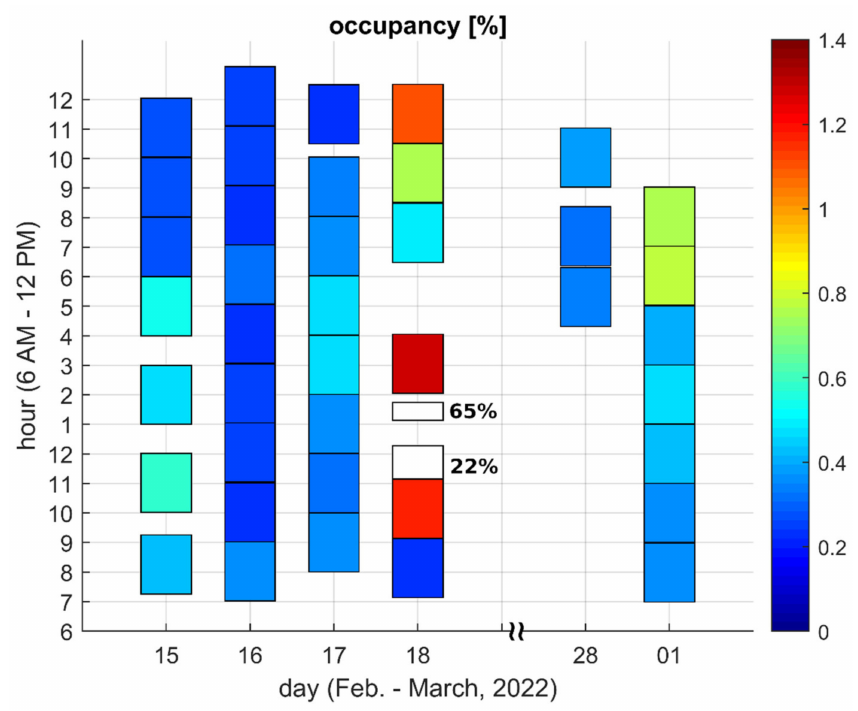
Figure 4. Channel occupancy for Location